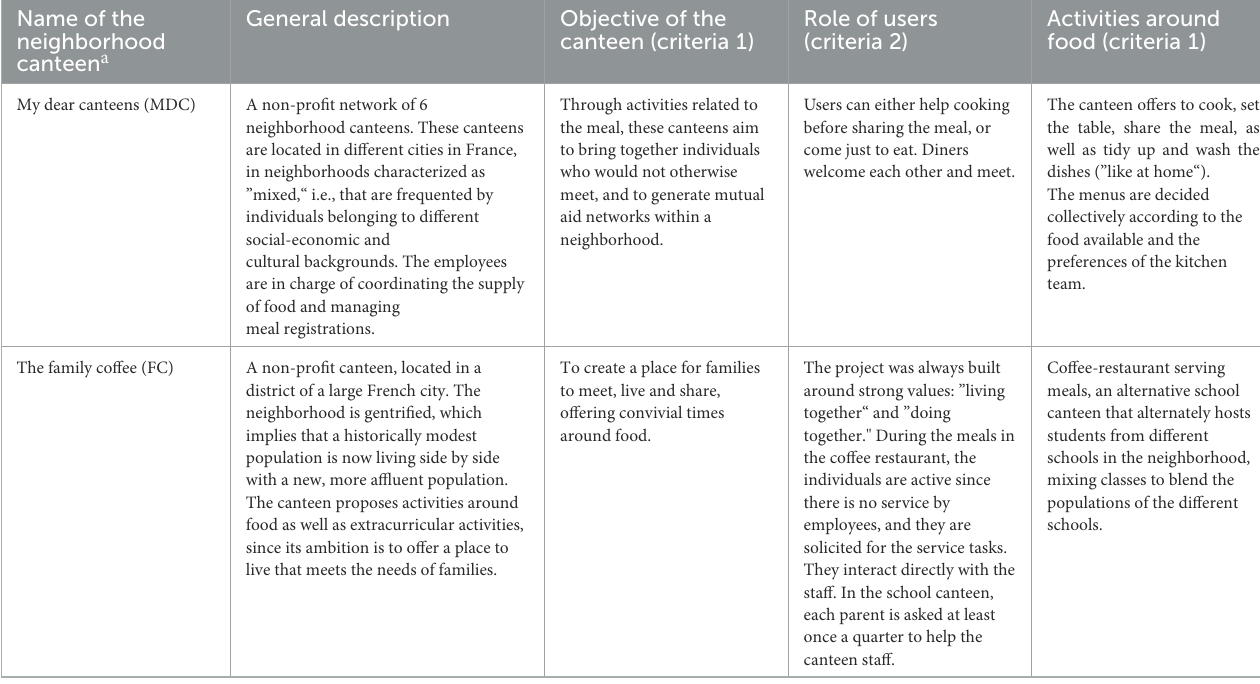
TABLE 1 Characterization of the canteens